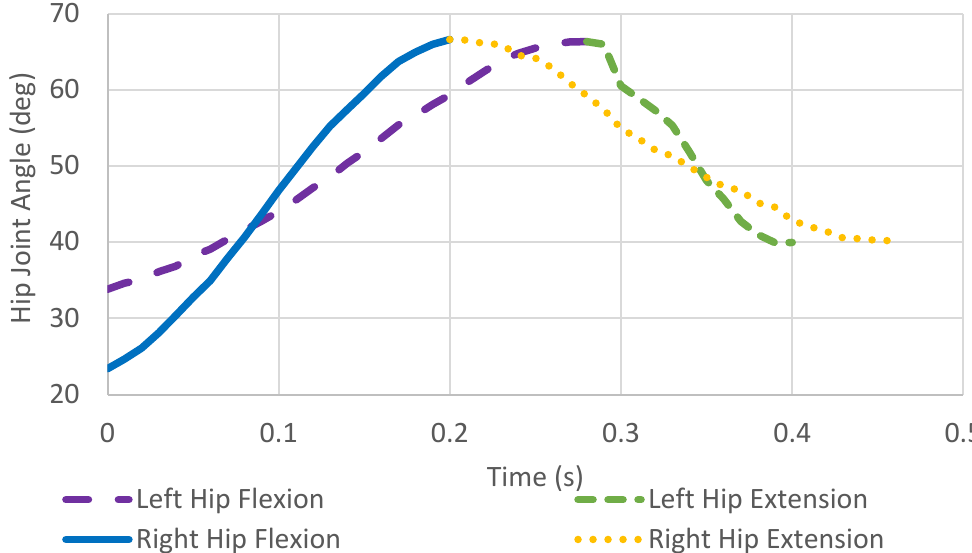
Figure 4. Hip joint angle data during discrete isolated kicks for right and left hips.